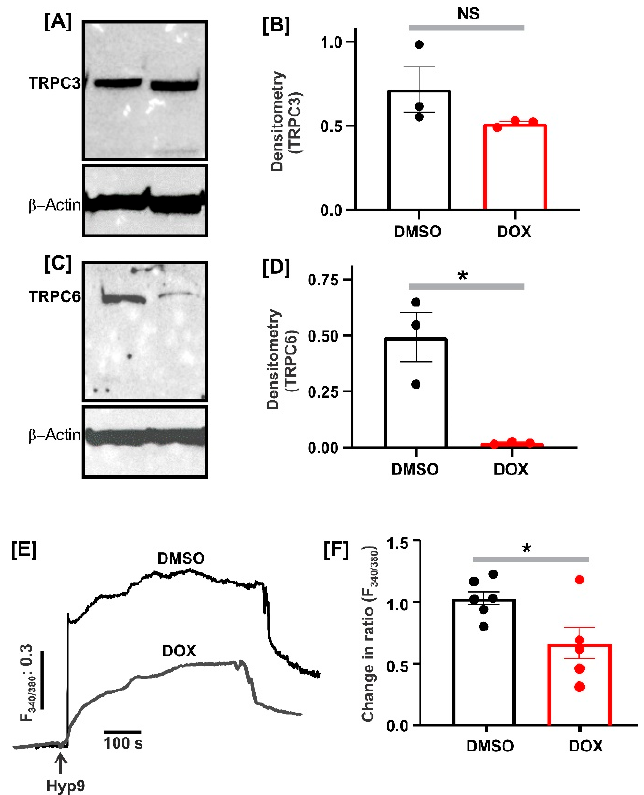
Figure 2. DOX reduces TRPC6 channel expression and TRPC6-mediated [Ca 2+ ] i in fetal GMCs. Western blot images and bar charts showing the expression levels of TRPC3 ( A , B ) and TRPC6 ( C , D ) in control (DMSO)- and DOX (100 nM)-treated fetal pig GMCs (18 h). ( E , F ) Exemplar traces and bar charts demonstrating the levels of Hyp9 (10 µM) (TRPC6 agonist)-induced [Ca 2+ ] i elevation in control (DMSO)- and DOX (100 nM)-treated fetal GMCs (18 h). * p < 0.05 vs. control (two-tailed unpaired t -test); NS = not significant.